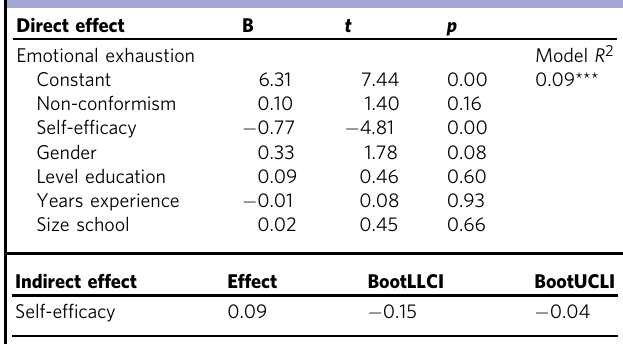
Table 5 Direct and indirect effects of self-ef fi cacy on emotional